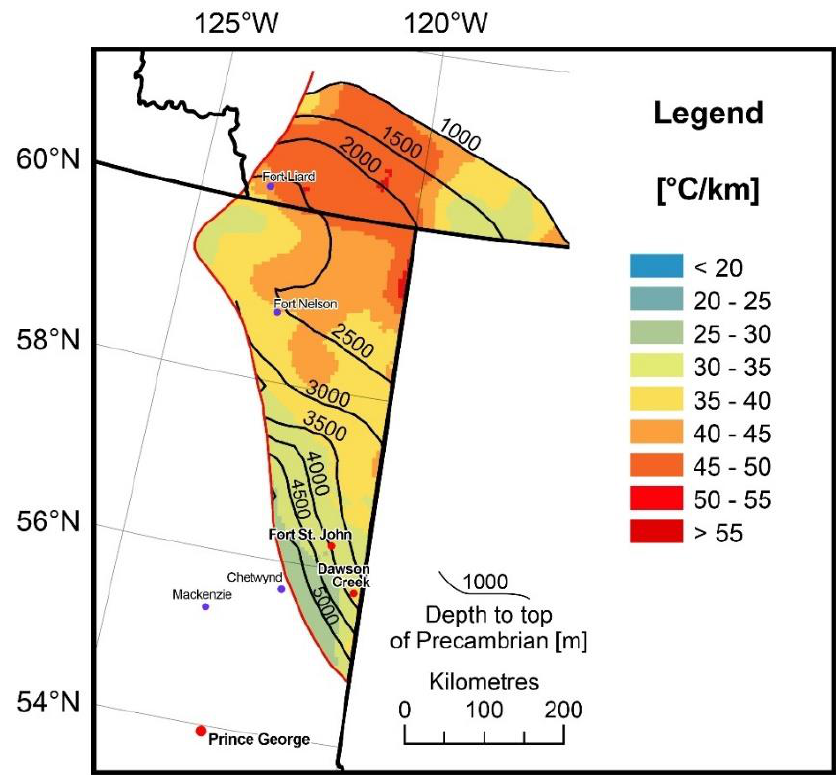
Figure A7. Geothermal gradient—NE British Columbia S. NWT WCSB.